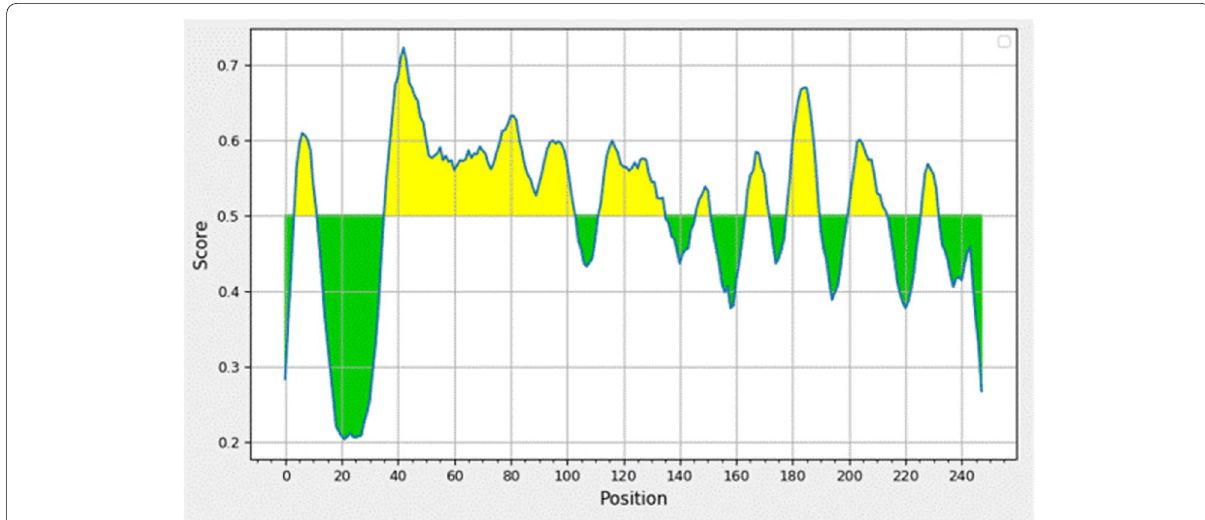
Fig. 4 BepiPred threshold graph of NHP1 protein predicting linear epitopes of NHP1 protein. Yellow color depicts the predicted epitope residues